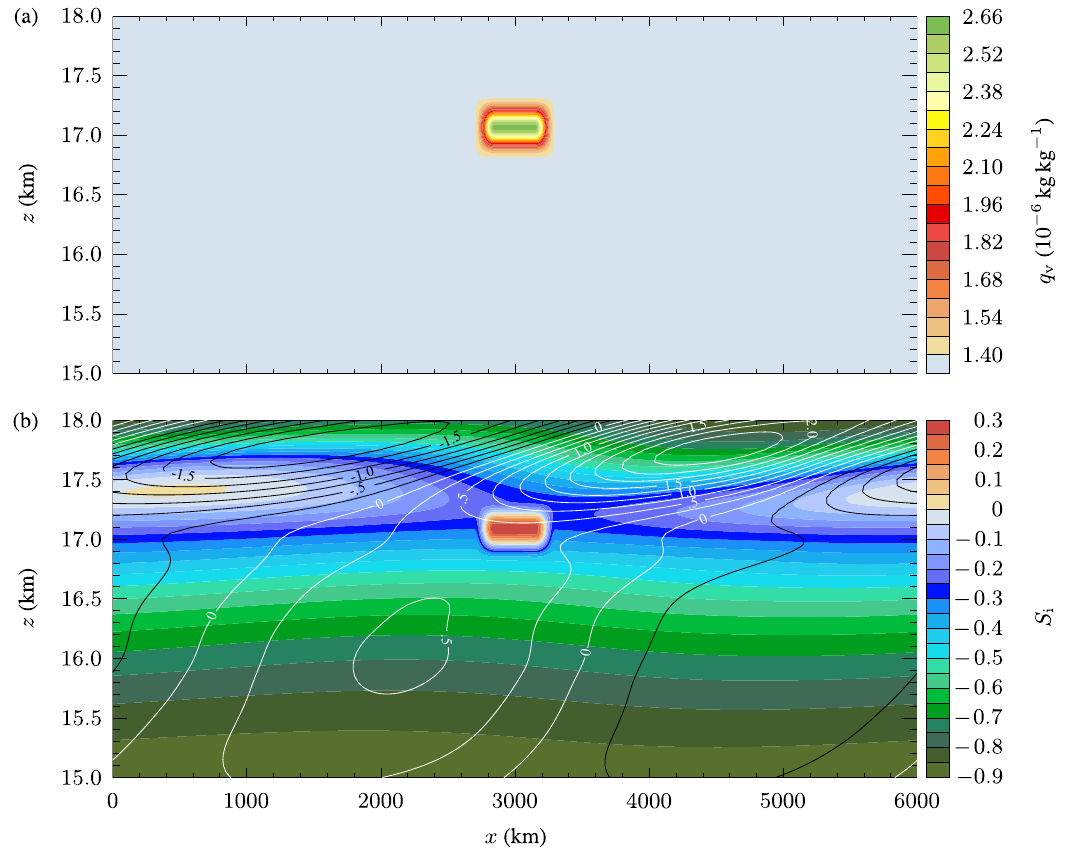
Fig. 4. Water vapor mixing ratio (a) and supersaturation ratio (b) at the initial time. In (b) , the black and white contours respectively show negative and positive large-scale wave temperature perturbations (K). Note that the vertical scale is exaggerated by a factor of about 10 3 to 1 compared with the horizontal